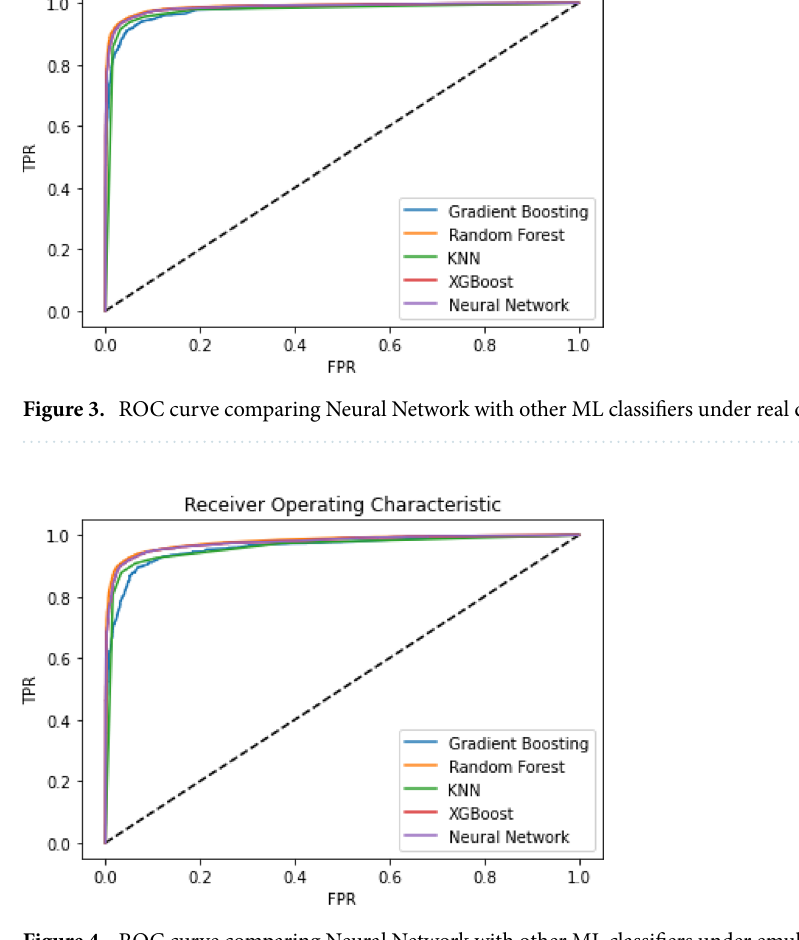
Figure 4. ROC curve comparing Neural Network with other ML classifiers under emulator device dataset.